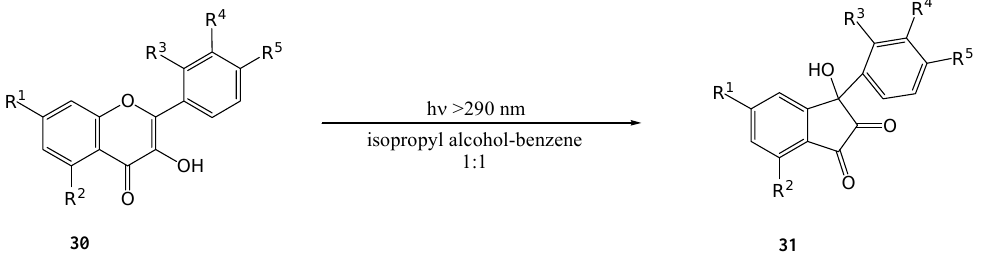
Table 2. Yields of indandiones obtained by photorearrangement of 3-hydroxyflavones.